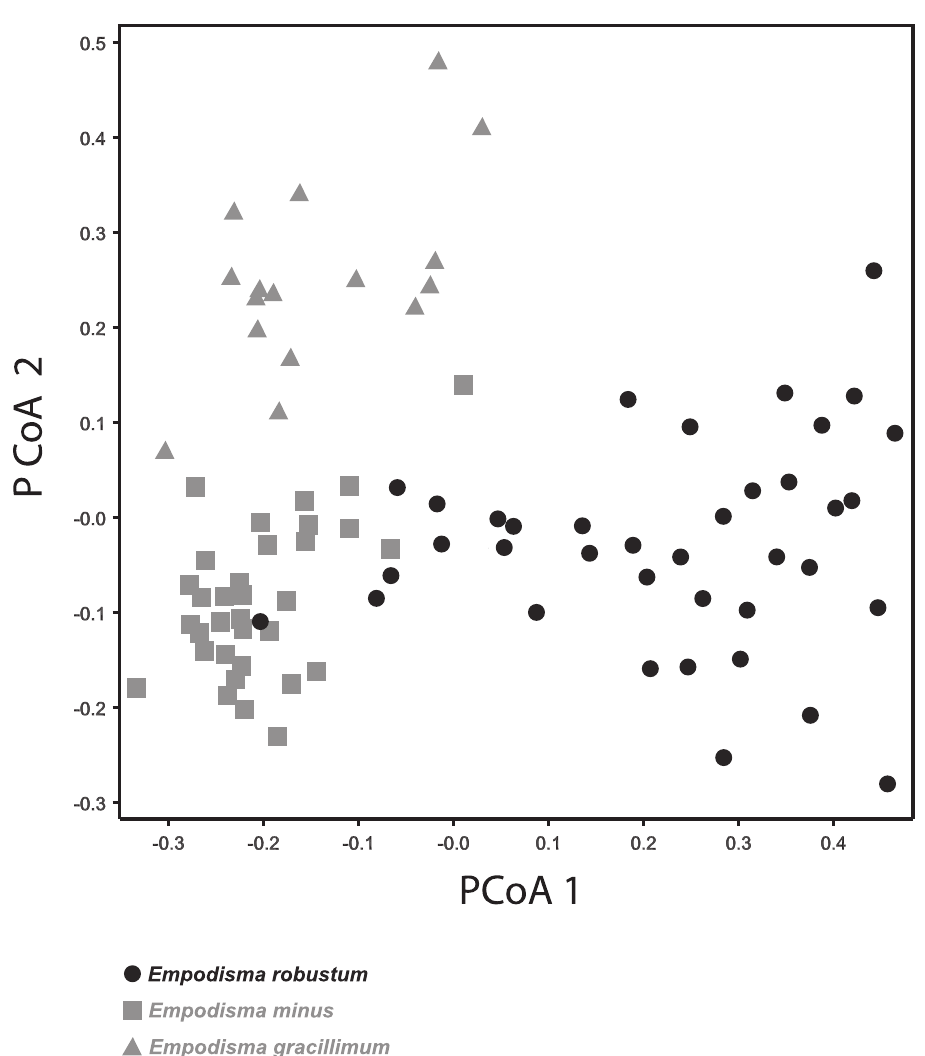
Figure 7. Principal coordinates ordination depicting patterns of overall similarity among the 74 OTEs that comprised our morphological sample. The first PC axis accounted for 58.3% of the variation in our sample and the second PC axis accounted for 23. 4% of the